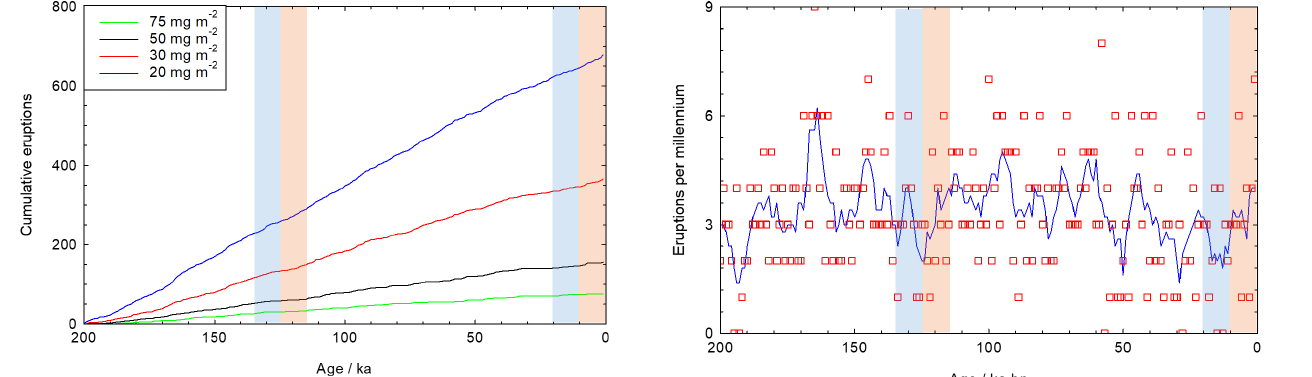
Figure 7. Eruption numbers per millennium (red) and 5kyr running mean (blue). Periods of deglaciation are marked with a blue bar and interglacials with an orange